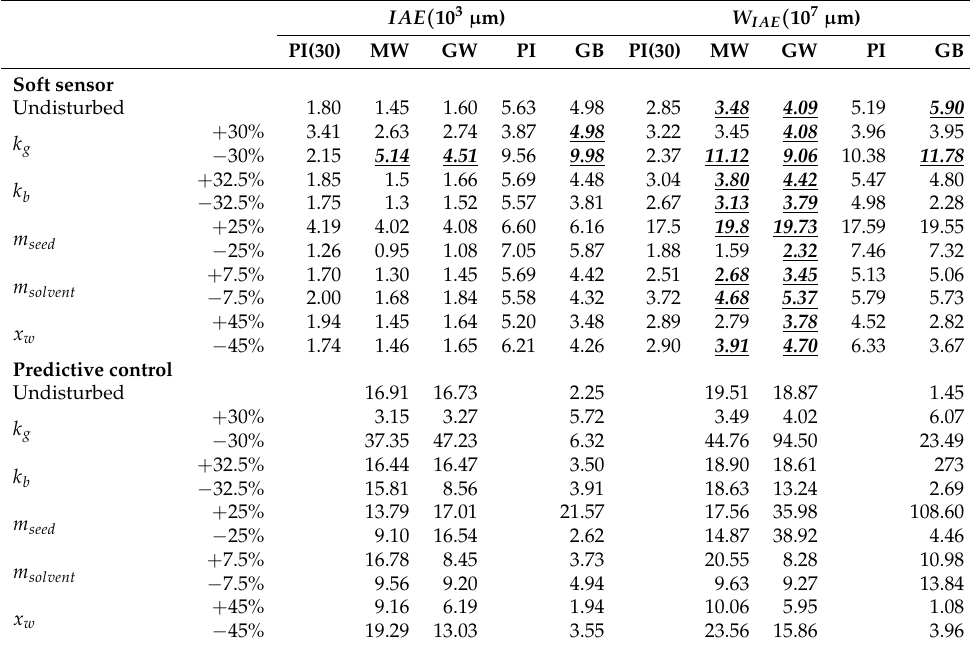
Table 3. Integral of the absolute error ( IAE ) and W IAE evaluation for the single step disturbances in the different RBF strategies.